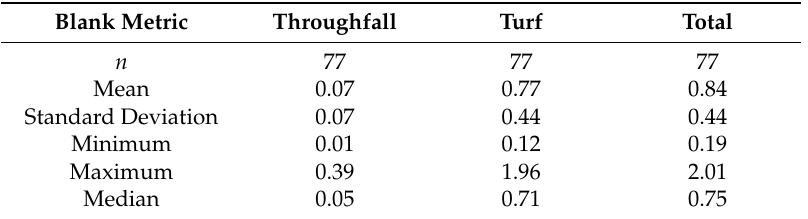
Table 2. Summary of total Hg ATSS field blanks at Florida sites